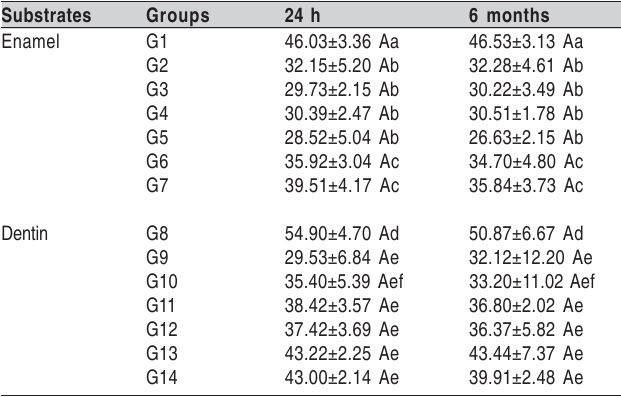
Table 2 - Micro-tensile bond strength of all experimental